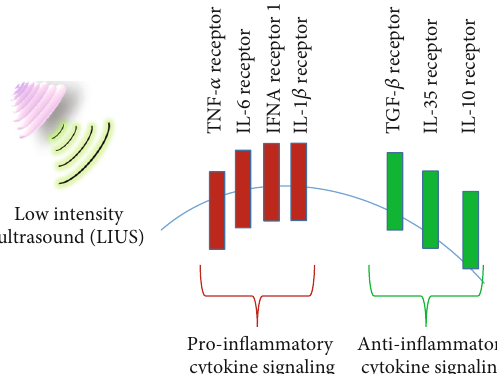
Figure 6: (a) By analyzing the microarray data from cytokine gene knock-out (KO) cells or cytokine-treated cells, we found that LIUS- upregulated innatomic genes (IIGs) (77 genes) in human lymphoma cells can be modulated by a set of cytokines. LIUS-upregulated IIGs are downregulated more than upregulated in proinflammatory cytokine tumor necrosis factor (TNF) KO cells (2 genes vs. 4 (5.2%)), interleukin-6 (IL-6) KO cells (3 genes vs. 8 (10.4%)), IL-1 𝛽 KO (3 genes vs. 4), and anti-inflammatory cytokine TGF- 𝛽 -treated lung carcinoma cells (8 genes vs. 22 (28.6%)). In addition, LIUS-upregulated IIGs are upregulated more than downregulated in anti- inflammatory cytokine IL-10 KO cells (5 genes vs. 3) (see supplemental Table 9 for details). Figure 6: (b) By analyzing the microarray data from cytokine gene KO cells or cytokine-treated cells, we found that LIUS-downregulated innatomic genes (39 genes) in human lymphoma cells can be modulated by a set of cytokines. LIUS-downregulated innatomic genes are upregulated more than downregulated in proinflammatory cytokine IL-6 KO cells (6 genes versus 5 genes), IL-1β KO (4 genes vs. 3 genes), and anti-inflammatory cytokine TGF- 𝛽 -treated lung carcinoma cells (12 genes vs. 7). In addition, LIUS-downregulated innatomic genes are upregulated more than downregulated in anti-inflammatory cytokine IL-10 KO cells (5 genes vs. 2) (see supplemental Table 10 for details). Figure 6: (c) By analyzing the microarray data from cytokine gene knock-out (KO) cells or cytokine-treated cells, we found that LIUS- upregulated innatomic genes (21 genes) in mouse preosteoblast cells can be modulated slightly by a set of cytokines. LIUS-upregulated innatomic genes are downregulated more than upregulated in proinammatory cytokine TNF-KO (0 gene vs. 1), IL-6 KO (absence vs. 1 gene), and anti-inflammatory cytokine TGF- 𝛽 -treated lung carcinoma cells (3 genes vs. 6 genes (28.6%)) and ovarian epithelial cells (3 genes vs. 8) (see supplemental Table 11 for details). Figure 6: (d) By analyzing the microarray data from cytokine gene knock-out (KO) cells or cytokine-treated cells, we found that LIUS- downregulated innatomic genes (17 genes) in mouse preosteoblast cells can be modulated slightly by a set of cytokines. LIUS-upregulated innatomic genes are upregulated more than downregulated in proinflammatory cytokine TNF-KO cells (3 genes vs. 1 gene) (see supplemental Table 12 for details). Figure 6: (e) By analyzing the microarray data from cytokine gene knock-out (KO) cells or cytokine-treated cells, we found that LIUS- upregulated innatomic genes (108 genes) in rat bone marrow cells can be modulated by a set of cytokines. LIUS-upregulated innatomic genes are upregulated more than downregulated in proinflammatory cytokine interleukin-6 (IL-6) KO cells (15 genes vs. 9) and IL-1 𝛽 KO cells (6 genes vs. 2). In addition, LIUS-upregulated innatomic genes are downregulated more than upregulated in anti-inflammatory cytokine transforming growth factor- 𝛽 - (TGF- 𝛽 -) treated cells (10 genes vs. 34 (31.5%)) (see supplemental Table 13 for details). Figure 6: (f) By analyzing the microarray data from cytokine gene knock-out (KO) cells or cytokine-treated cells, we found that LIUS- downregulated innatomic genes (182 genes) in rat bone marrow cells can be modulated by a set of cytokines. LIUS-downregulated innatomic genes are upregulated more than downregulated in proinflammatory cytokine TNF-KO cells (14 genes vs. 10) and IL-6 KO cells (17 genes vs. 9). In addition, LIUS-downregulated innatomic genes are upregulated more than downregulated in anti-inflammatory cytokine Il-35-treated cells (5 genes vs. 2). Moreover, LIUS-downregulated innatomic genes in bone marrow cells are significantly upregulated in TGF- 𝛽 -treated lung carcinoma cells (39 genes (21.4%) vs. 12) (see supplemental Table 14 for details). Figure 6: (g) Low-intensity ultrasound (LIUS) therapy modulates the expressions ofinnatomic genes partially via using the signaling pathways offour proinflammatory cytokines, namely, tumor necrosis factor- 𝛼 (TNF- 𝛼 ), interferon 𝛼 (IFN- 𝛼 ), interleukin-6 (IL-6), and IL-1 𝛽 , and three anti-inflammatory cytokines, namely, transforming growth factor- 𝛽 (TGF- 𝛽 ), IL-35,